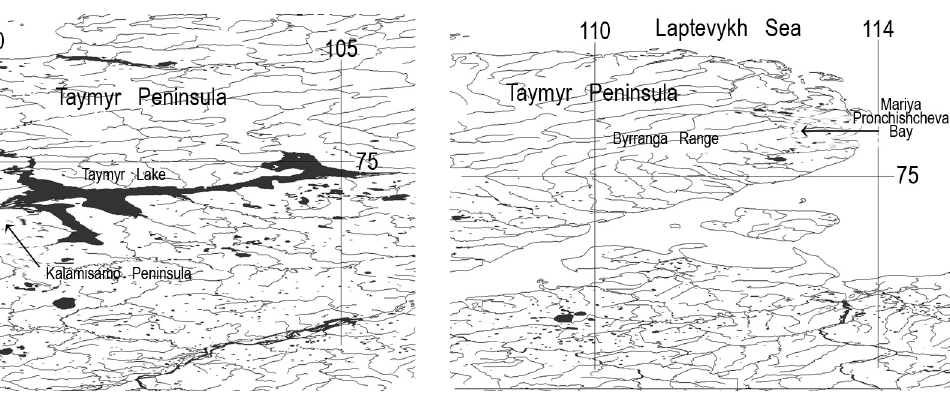
Fig. 12. Map of Kalamisamo Peninsula (Taymyr Lake) calving grounds.